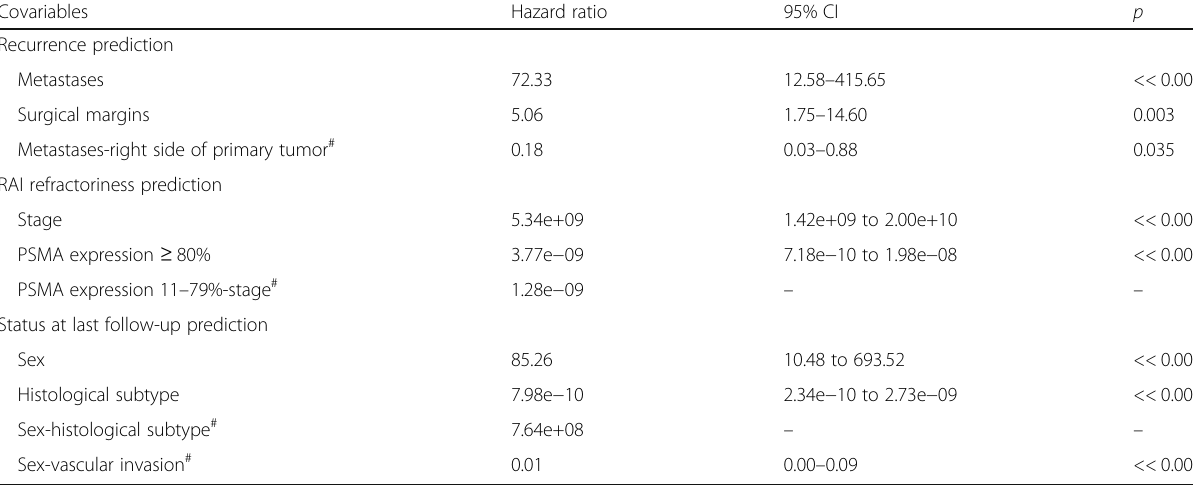
Table 5 Multivariate Cox models to predict